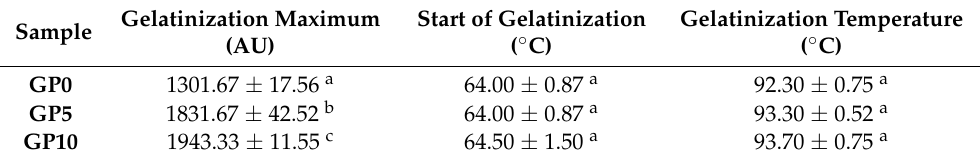
Table 3. Amylograph characteristics of dough supplemented with grape pomace powder.